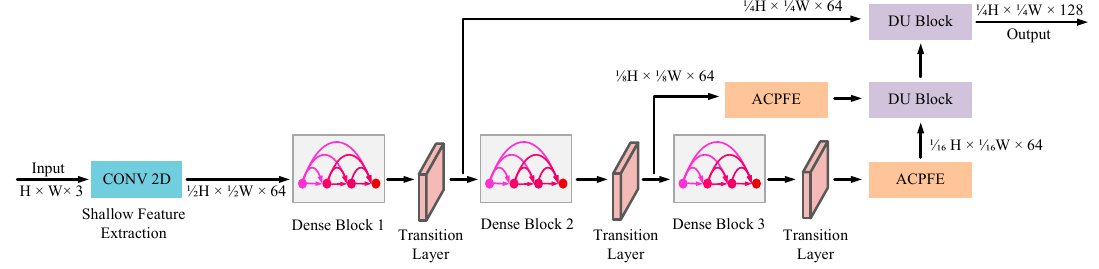
Figure 2. The structure of the Siamese feature extraction.